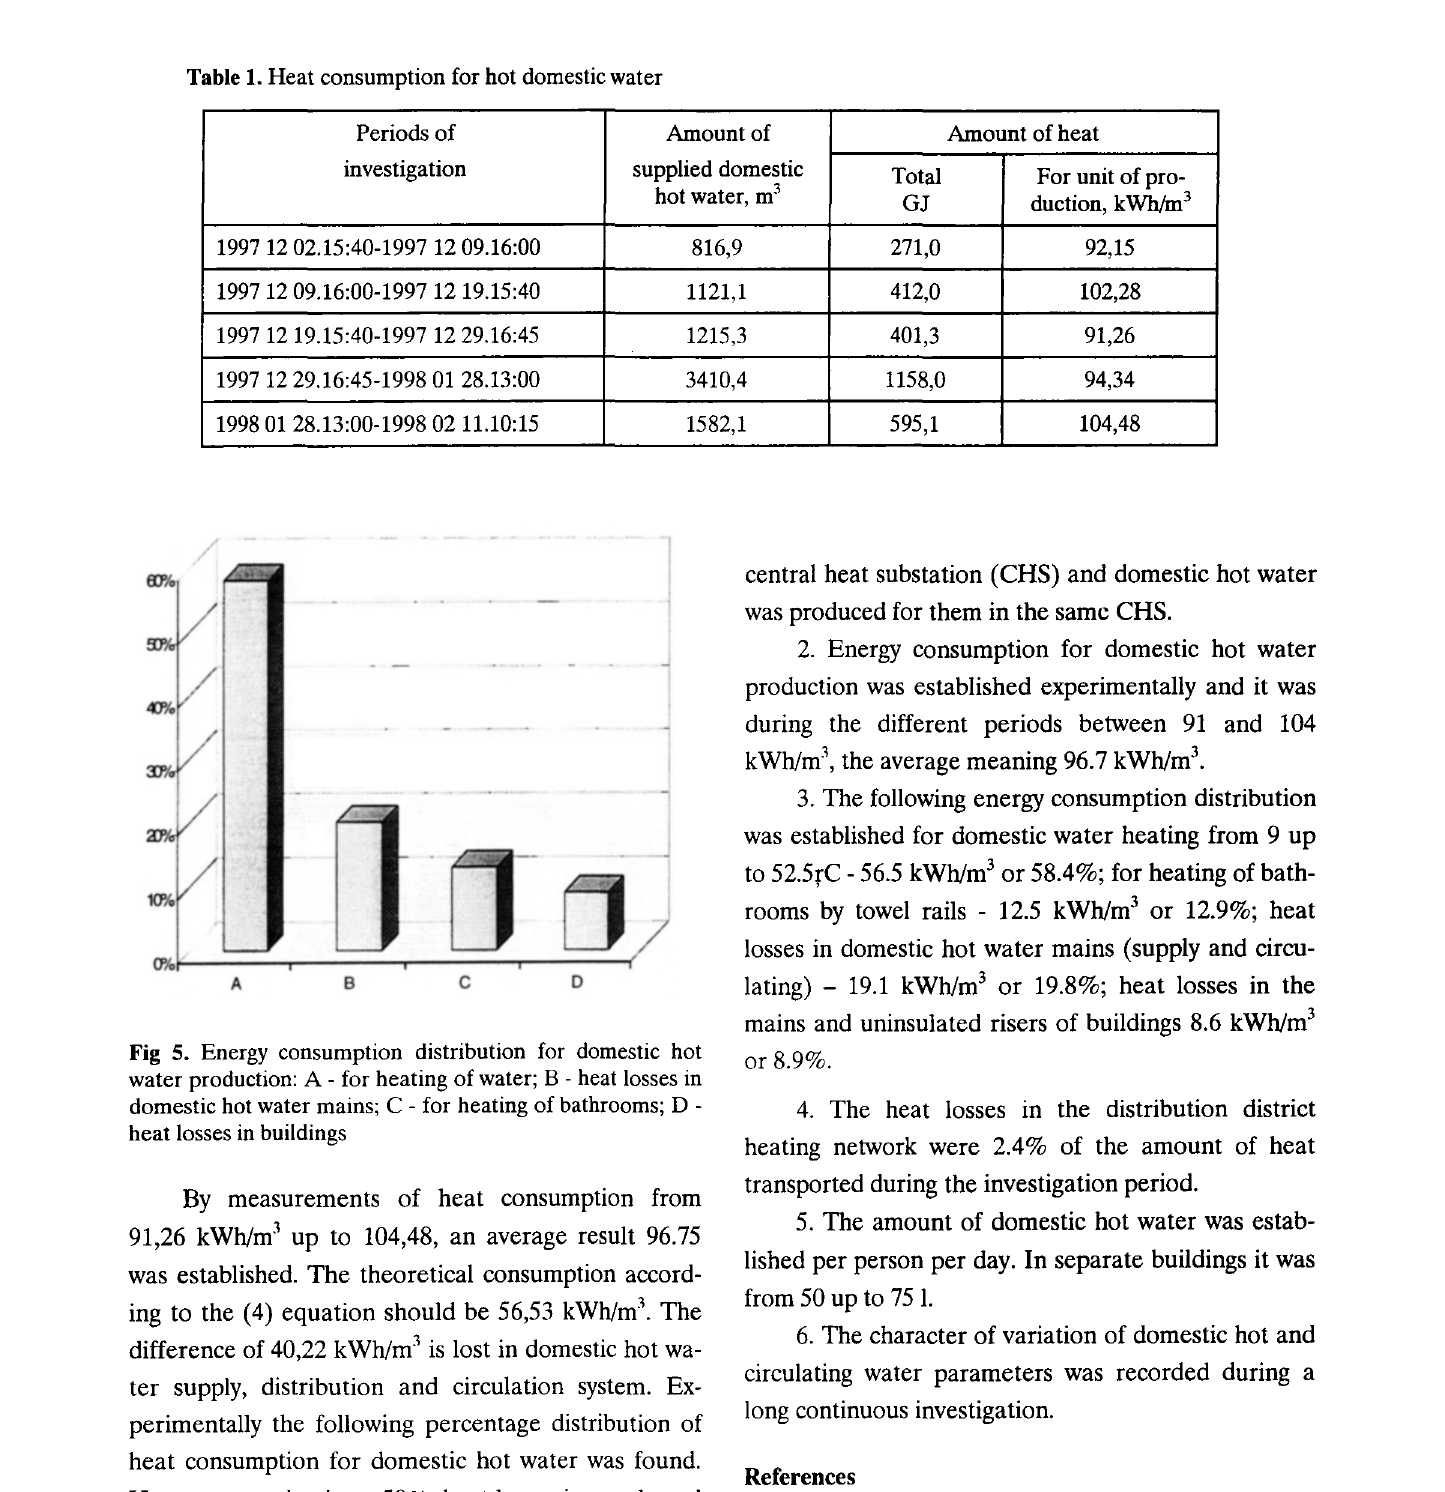
Fig 5. Energy consumption distribution for domestic hot water production: A - for heating of water; B - heat losses in domestic hot water mains; C - for heating of bathrooms; D - heat losses in buildings By measurements of heat consumption from 91,26 kWh/m 3 up to 104,48, an average result